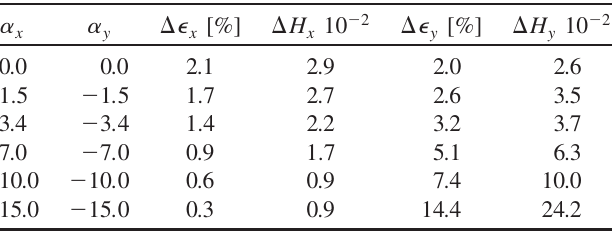
TABLE XII. Divergence dependence—Gaussian beam